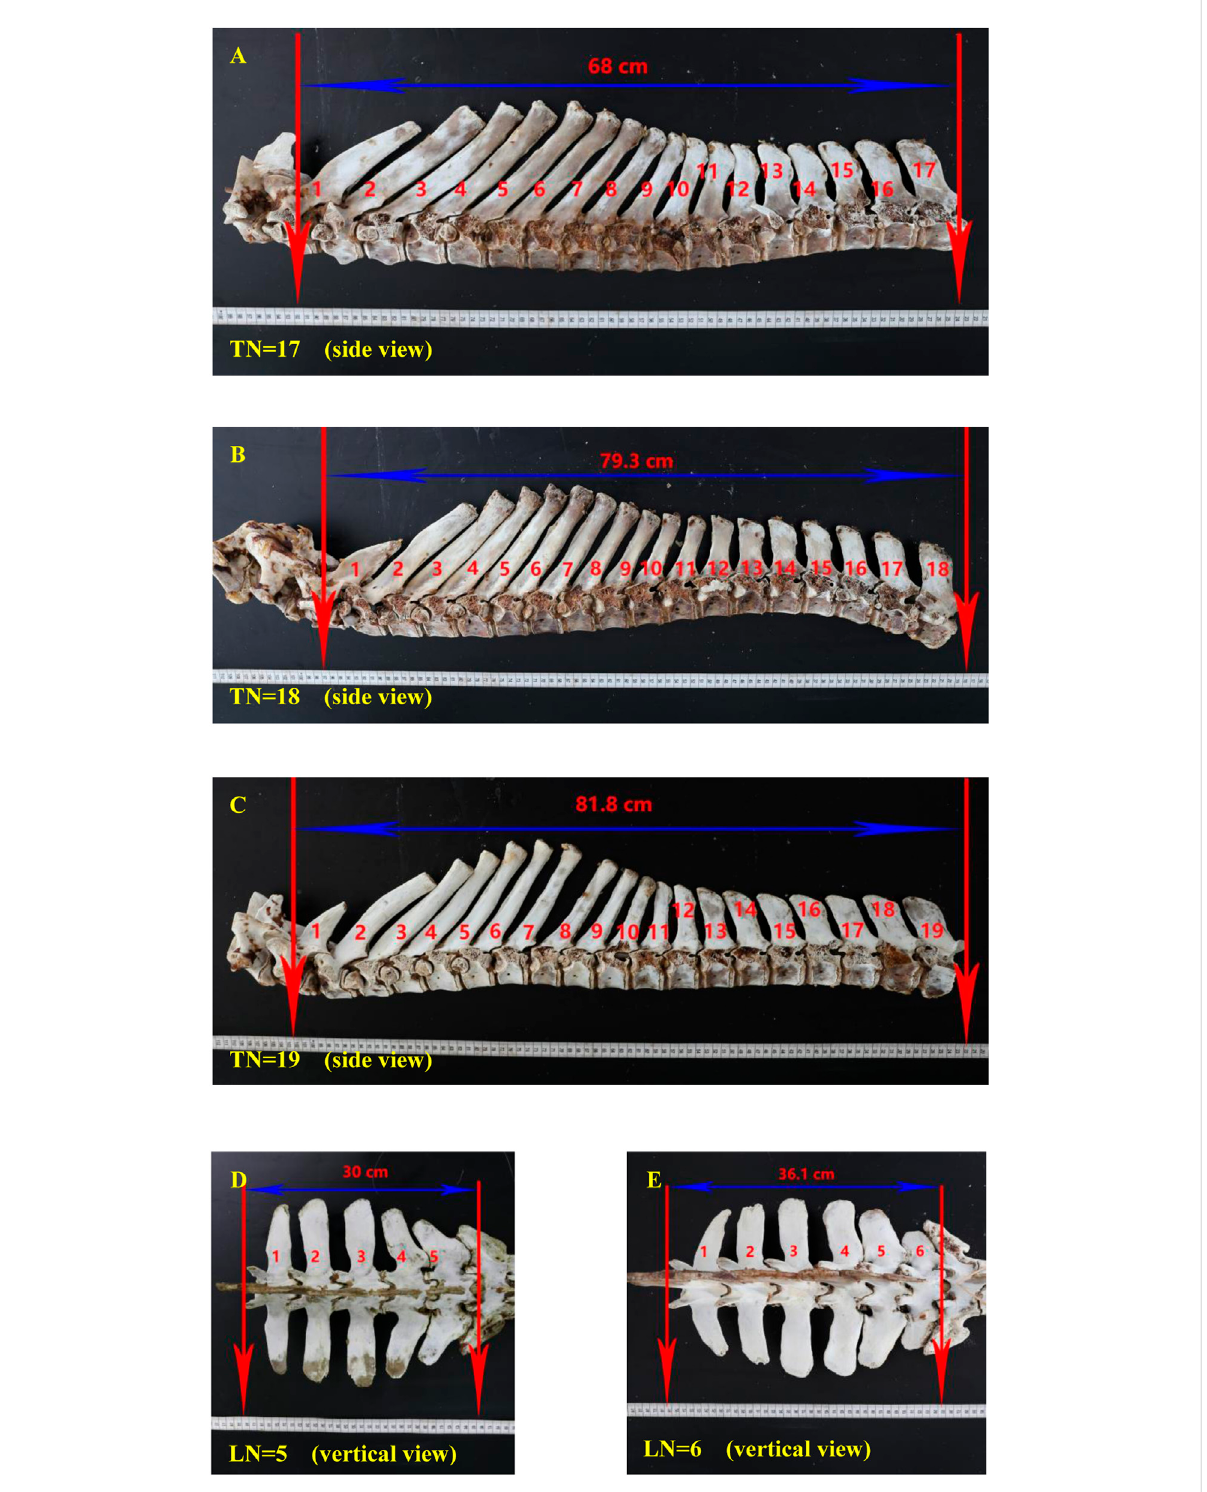
FIGURE 1 Thoracic andlumbarvertebraespecimensofDezhou donkeys.Notes: (A) thesideviewofa17thoracicvertebrae specimen; (B) thesideview of an18thoracicvertebraespecimen; (C) thesideviewofa19thoracicvertebraespecimen; (D) theverticalviewof5lumbarvertebraespecimen; (E) the vertical view of 6 lumbar vertebrae specimen. In each fi gure, the red arrows mark the starting and ending points of the thoracic or lumbar vertebrae, respectively. Thebluearrows indicatethestraight-linelengthofthethoracicorlumbarvertebrae.Rednumberswith unitsindicatethestraight- line length value of the thoracic or lumbar vertebrae. Red numbers without units indicate the order of the thoracic or lumbar vertebrae. “ LN ” means the number of lumbar vertebrae; “ TN ” means the number of thoracic